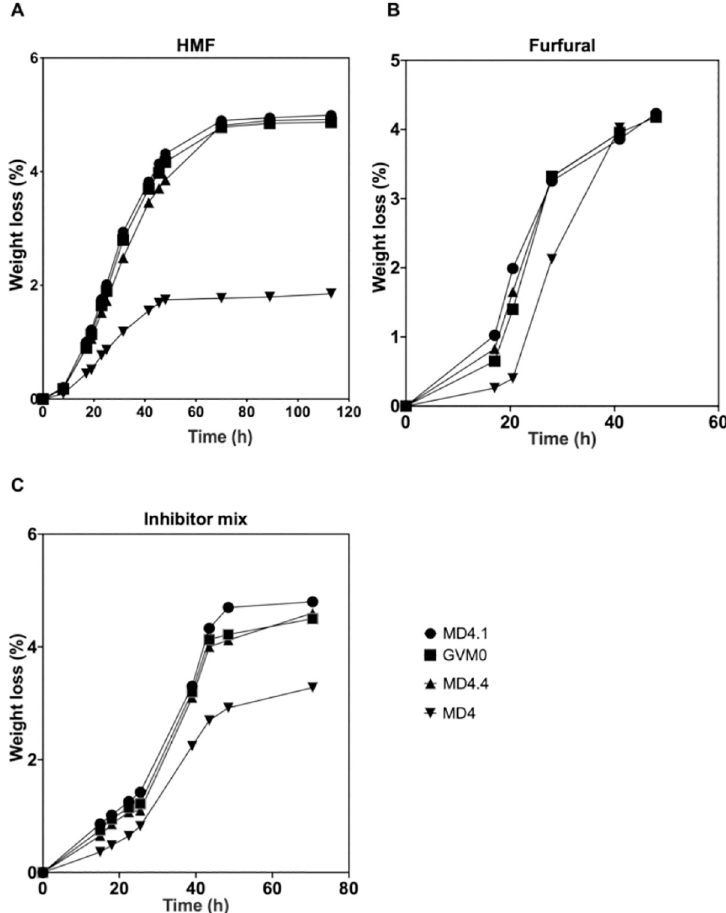
Fig 4. Fermentation performance of MD4, MD4 with one or four copies of AST2 N406I and the GVM0 WG transformant in the presence of HMF, furfural or a mixture of inhibitors. Small-scale fermentations (10 mL) were performed at 35˚C, 350 rpm, initial OD 5.0 in (A) YPDX enriched with 12.0 g/L HMF at pH 5.2, (B) 4.0 g/L furfural at pH 5.2 or (C) a mixture of 2.80 g/L HMF, 1.75 g/L furfural, 0.35 g/L vanillin and 4.20 g/L acetic acid at pH 4.6, to have a starting pH lower than the pKa of acetic acid (4.76). MD4.4: MD4 with four copies of AST2 N406I ; MD4.1: MD4 with one copy of AST2 N406I ; MD4: with four wild type AST2 alleles; GVM0: original WG transformant with a single copy of AST2 N406I . Representative result of two biological replicates is